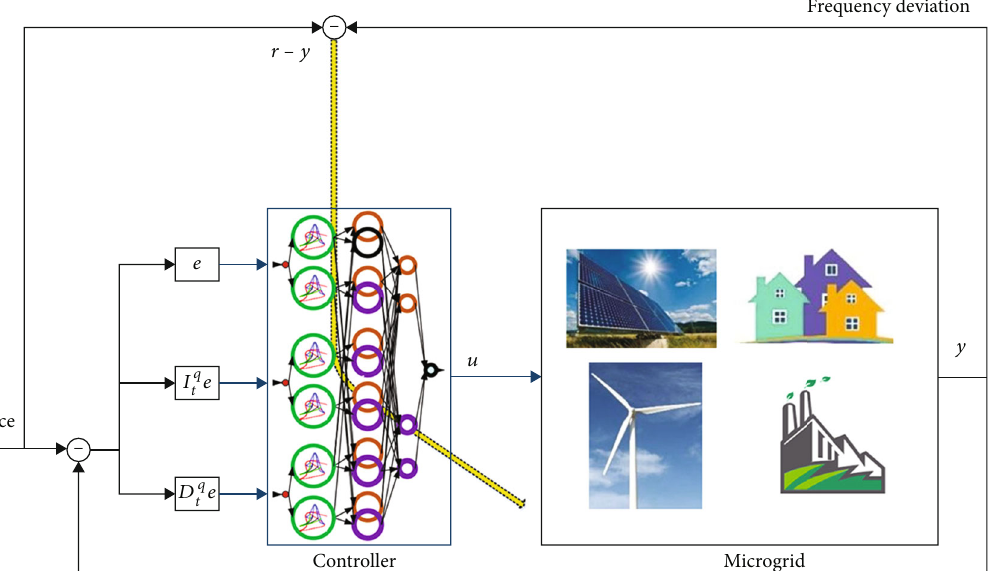
Figure 2: General view.